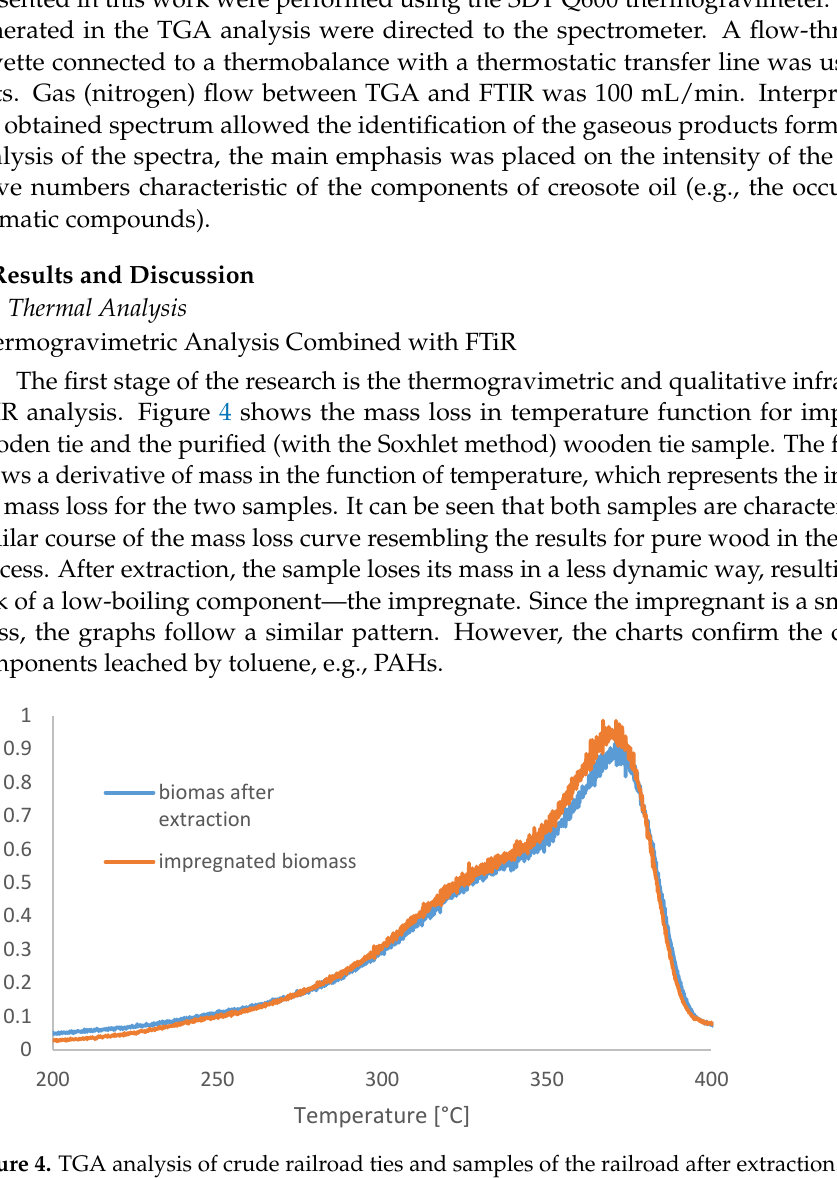
Figure 5. FTIR analysis of the purified wooden tie sample.